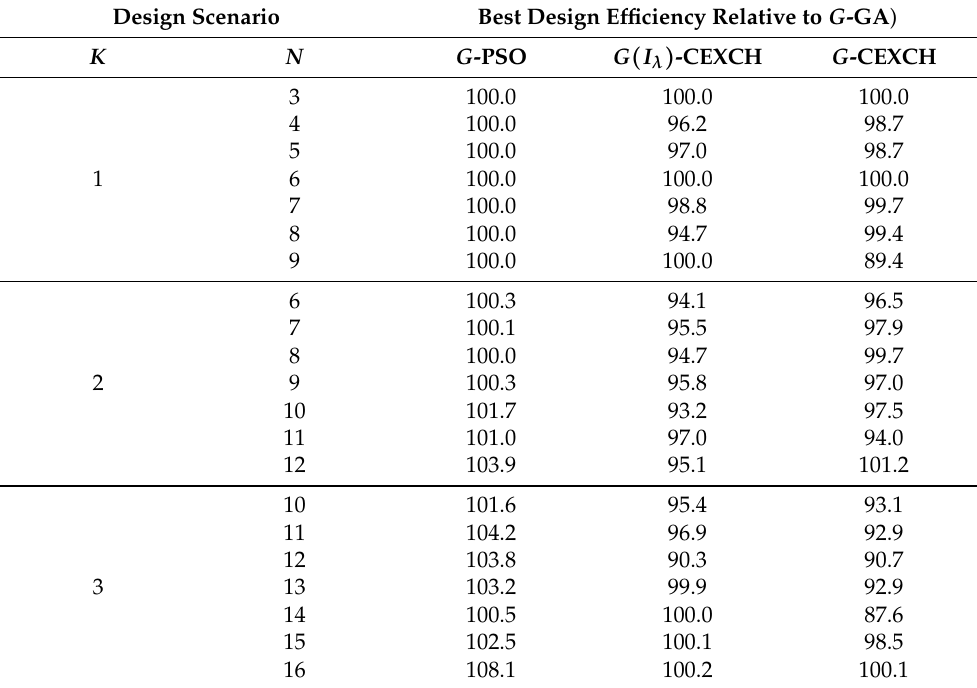
Table 2. Relative efficiencies of G -optimal designs for each algorithm relative to GA generated designs of [10].